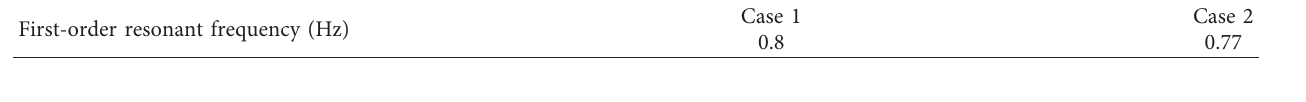
Table 2: Experimental